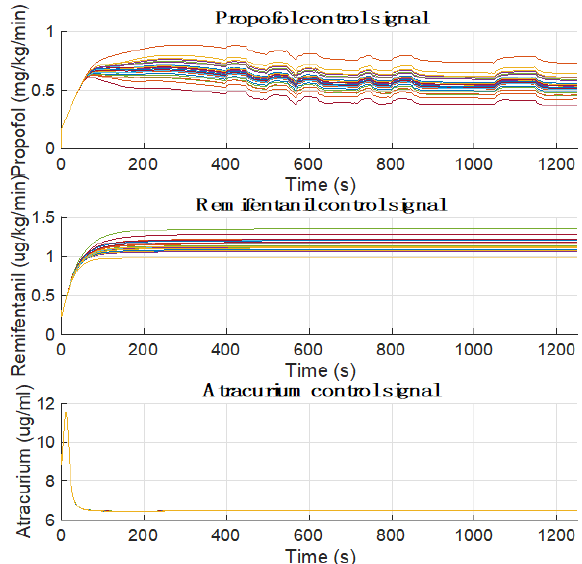
Figure 16. Propofol and Remifentanil control signals—simulation results with the proposed fractional-order switching function on all 24 patients.